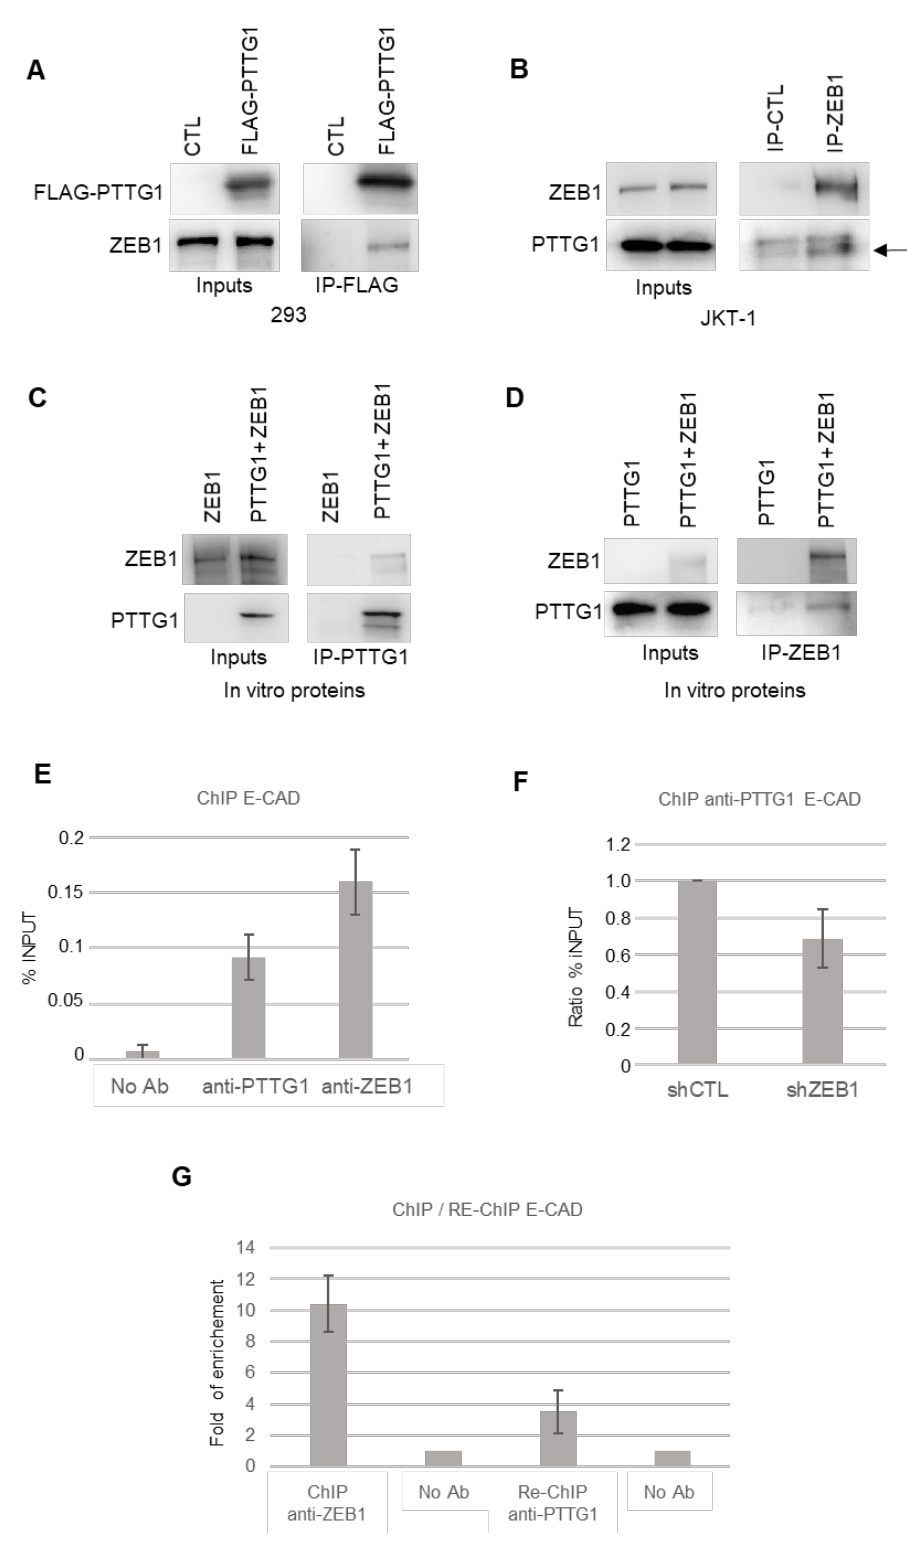
Figure 3. PTTG1 interacts with ZEB1. ( A ) Western blot analysis (Wb) of the indicated proteins. Inputs represent 1/10 of the total protein used in immunoprecipitation of FLAG-PTTG1 (IP-FLAG) in 293T cells transfected with FLAG-PTTG1 or control plasmid (CTL). ( B ) Western blot analysis (Wb) of the indicated proteins. Inputs represent 1/10 of the total protein used in immunoprecipitation of control (IP-CTL) or ZEB1 (IP-ZEB1) in JKT-1 cells. Arrow indicates PTTG1-specific band in right